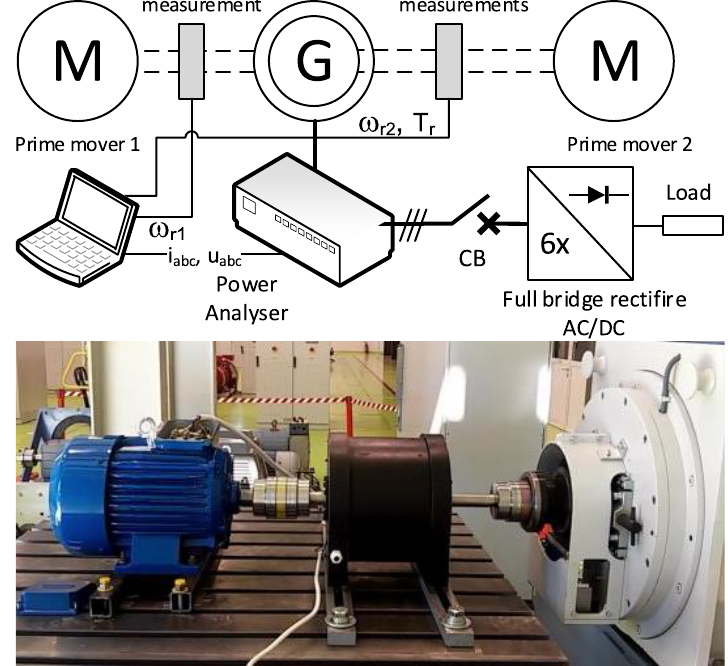
Figure 11. Dynamometer test bench configuration during the